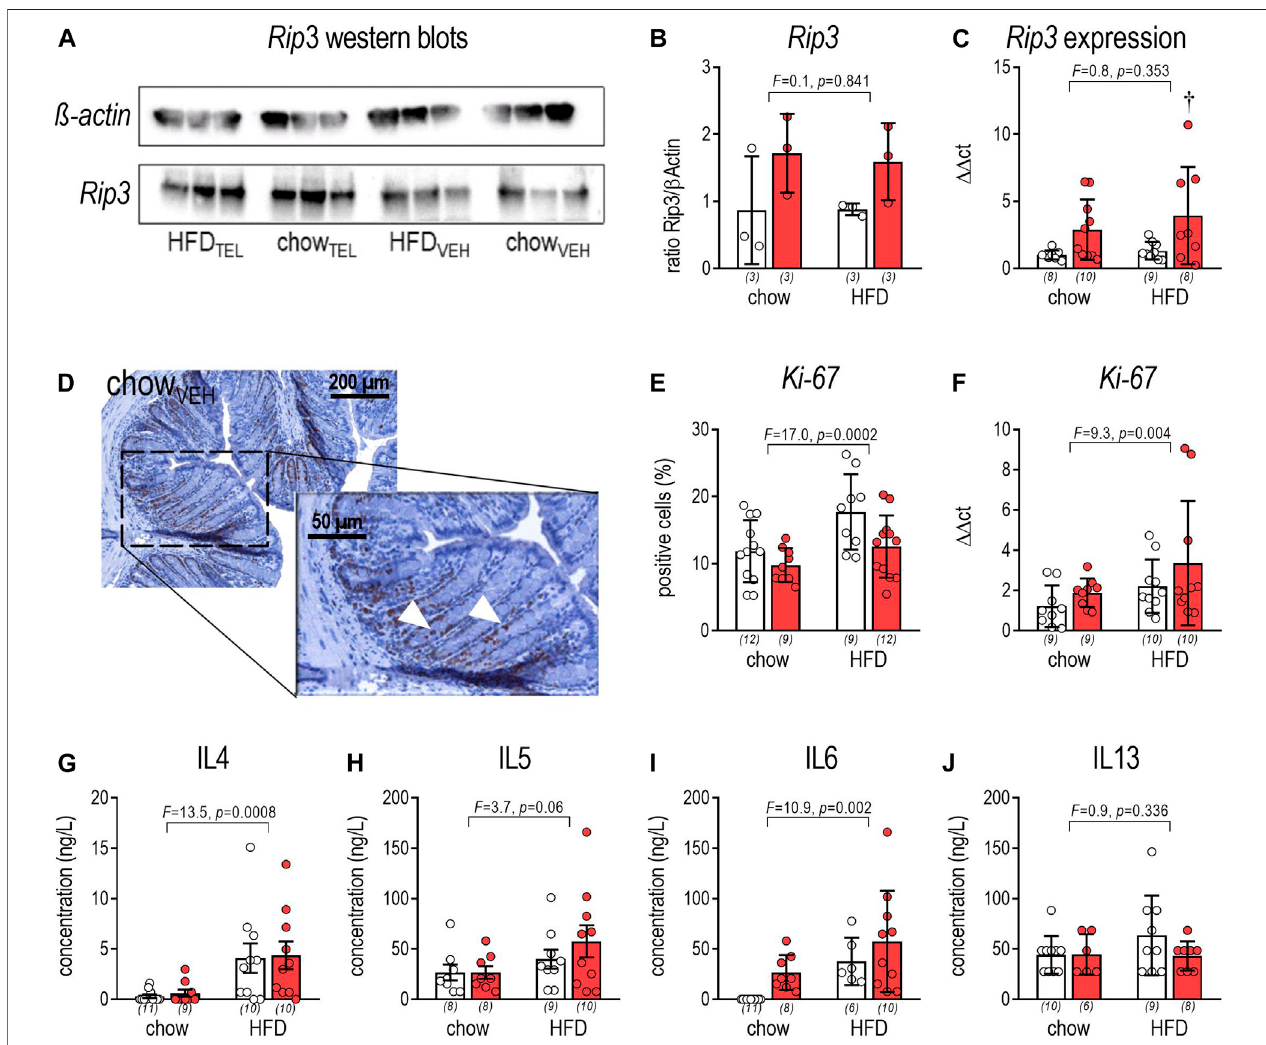
FIGURE5 | Effects ofTEL ( C , 8 mg/kg/day red bars) or vehicle treatment open bars (O)on largeintestine on necroptosis, proliferation, and in fl ammation. (A) Rip3 western blots; (B) Rip3/ β -actin ratio (two-way ANOVA; TEL: F = 5.5, p = 0.047, interaction; F = 0.1, p = 0.841); (C) Rip3 expression in large intestine (two-way ANOVA; TEL: F =9.6, p =0.004,interaction; F =0.3, p =0.616); (D) stainingagainst Ki-67invehicletreatedchow-fedcontrols;Ki-67positivecellsareindicatedbyanarrow. ; (E) Ki-67 -positive cells (Staining was evaluated using ImageJ (version 2.0.0-RC-54/1.51 h), in which 4 areas of interst were de fi ned for each animal, with the same number of pixels for each image. Within this area, the percentage of Ki-67 positive cells was measured, averaged, and expressed as a percentage based on the Ki-67 labelingindex;two-wayANOVA;TEL: F =20.1, p < 0.0001,interaction; F =2.9, p =0.097); (F) Ki-67 expression(two-wayANOVA;TEL: F =6.6, p =0.0146,interaction; F =1.2, p =0.278);plasmalevelsafter 12 weeksofIL4(G;two-way ANOVA; TEL: F =0.1, p =0.785,interaction; F < 0.01, p =0.991);IL5(H, two-way ANOVA; TEL: F = 0.6, p = 0.445, interaction; F = 0.06, p = 0444); IL6 (I; two-way ANOVA; TEL: F = 5.0, p = 0.032, interaction; F = 0.1, p = 0.739); IL13 (J; two-way ANOVA; TEL: F = 1.2, p = 0.287, interaction; F = 1.3, p = 0.256). Means ± SD, † p < 0.05 vs. HFD VEH . The individual group size is indicated below the bars in